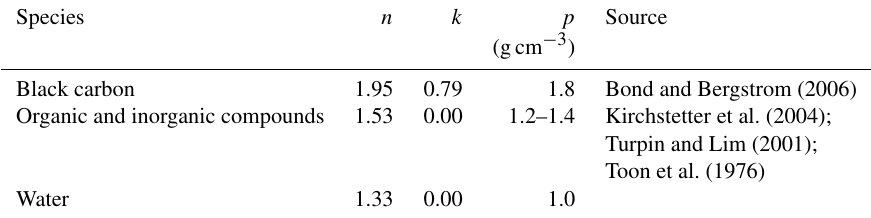
Table 1. Real ( n ) and imaginary ( k ) parts of refractive index, and density ( p ) of the components used in the Maxwell Garnett effective medium approximation calculations. All components were assumed to have spectrally flat refractive index. Uncertainty in p for the species represented by the second inclusion was propagated into combined errors of retrieved water volume fraction and particle